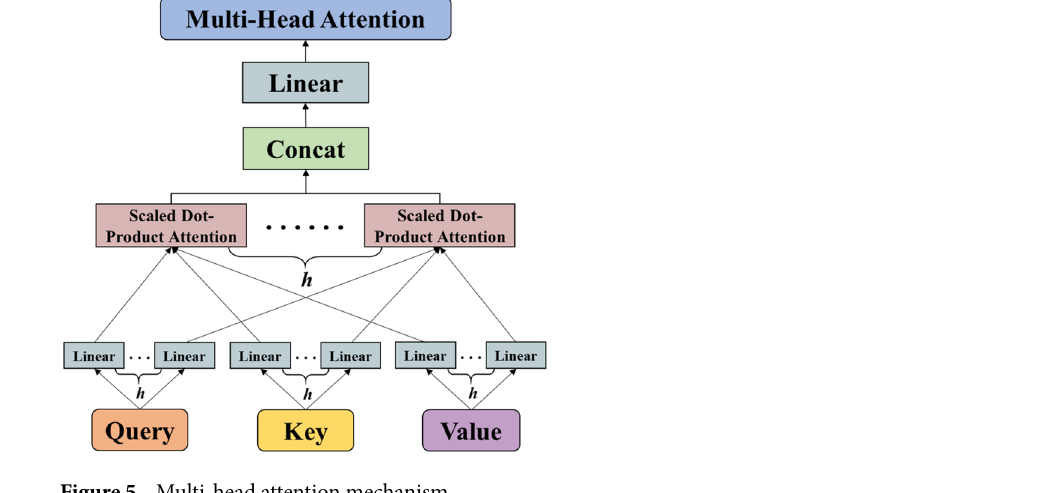
Figure 5. Multi-head attention